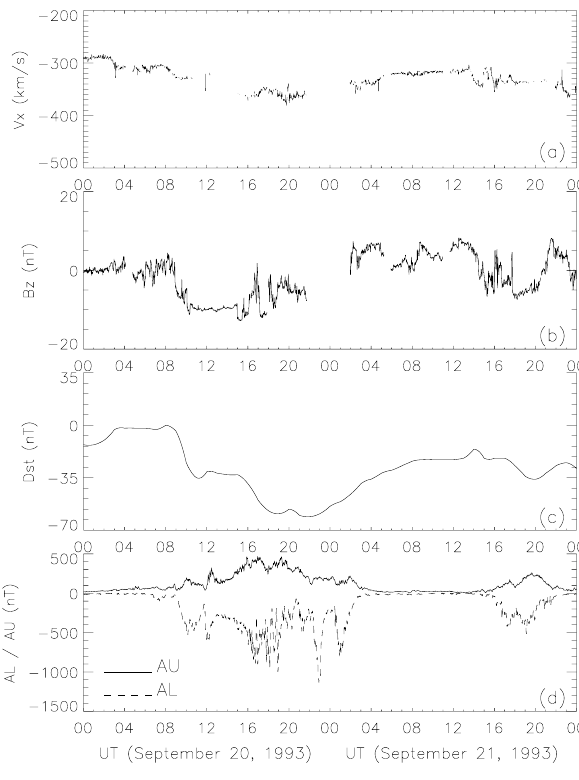
Fig. 2. Idem as Fig. 1, for the period No